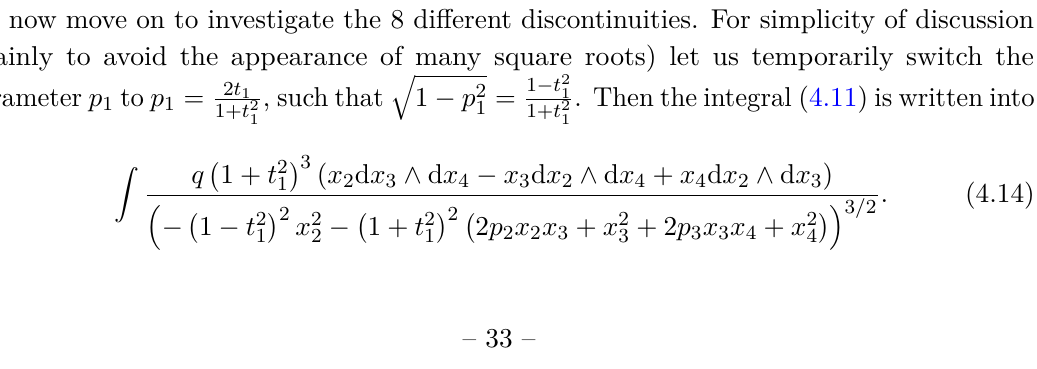
is also a quadric, which is birational to CP 1 and so is simply V V 1 i j